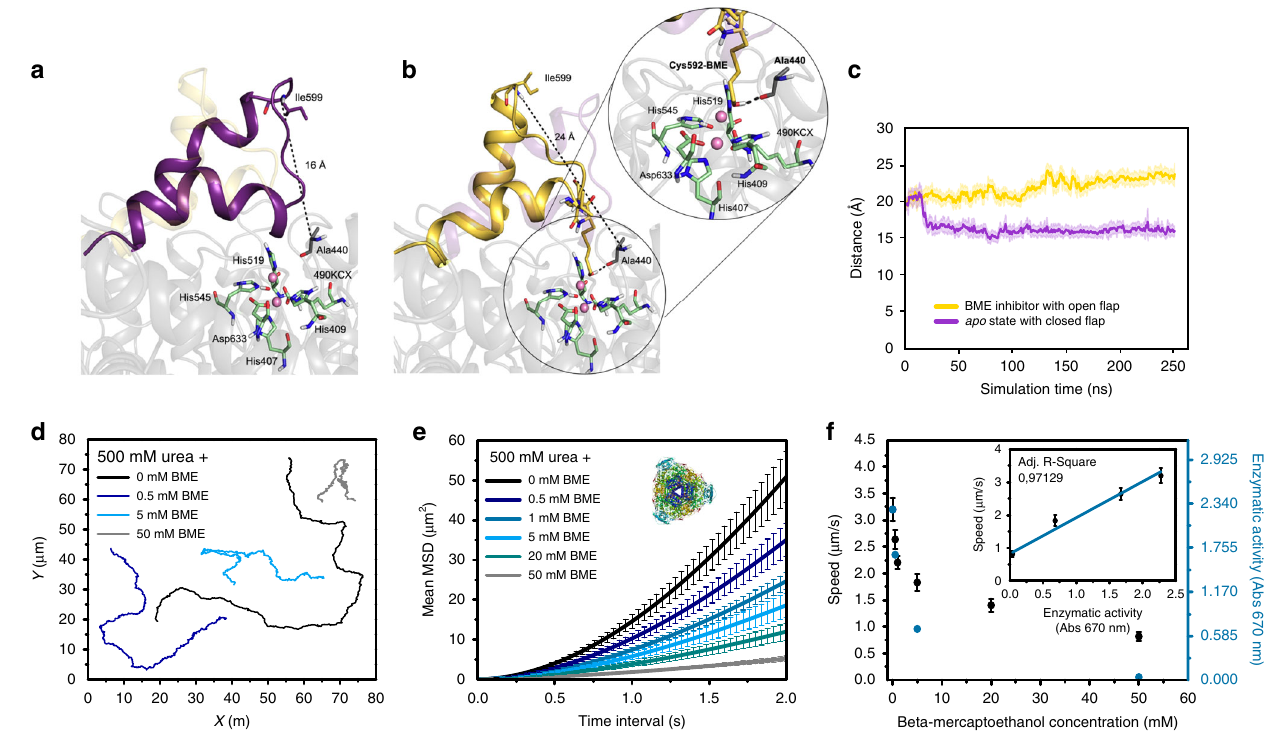
Fig. 6 Conformation of UR and motion behavior of UR-HSMM exposed to BME. Representative snapshots taken from the MD simulations of a UR in apo state where the fl ap covering the active site can adopt a closed conformation (purple) and b BME which stabilizes more open conformations of the fl ap (yellow). The zoom of the active site residues shows catalytic residues in green, nickel atoms in pink, and the Cys592-BME inhibitor in yellow. c MD simulated fl ap distance between Ala440 – Ile599 in the apo state (purple) and Cys592-BME state (yellow). Closed conformations have distances of about 16 Å while open conformations have 25 Å. Results are shown as the mean ± standard deviation (s.d.). d Representative trajectories of UR-HSMM exposed to 500 mM urea and different concentrations of BME. e Average MSD representation of UR-HSMM exposed to BME with urea present in excess (500 mM). Enzyme structures are extracted from RCSB PDB (see Supplementary Note 3). f Average speed of UR-HSMM, extracted from the MSD analysis and enzymatic activity for different BME concentrations with urea present in excess (500 mM). Inset: correlation of speed of UR-HSMM and its enzymatic activity depending on inhibition. Results are shown as the mean ± s.e.m. 22 Particles were analyzed for 0 and 50 mM BME, 19 particles were analyzed for 0.5 and 20 mM BME, and 21 particles were analyzed for 1 and 5 mM BME. Source data are provided as a Source Data fi